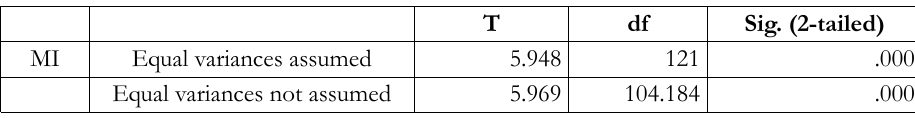
Table 5. The result of MI Data t-test